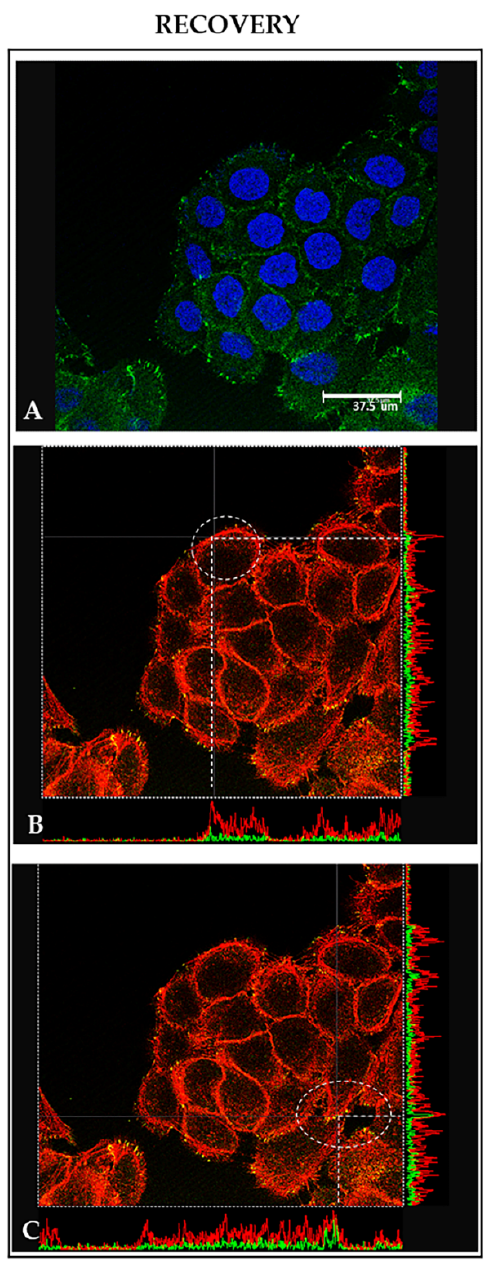
Figure 6. Representative images of colocalization analysis of vinculin (green) and F-actin (red) in HaCaT cells cultured in RPM for 24 h and then transferred into a normal gravitational field for a further 24 h (recovery conditions). In ( A ), vinculin distribution is shown; vinculin recovers almost completely the distribution pattern observed in 1g cultured cells. ( B , C ) Colocalization analysis of F-actin and vinculin. In the X/Y axes, at the level of the dotted lines, the colocalization (green and red picks) is shown. Colocalization in the recovery condition appears mainly in cell–cell contacts (( C ), dotted circle), while none or little colocalization is observed at the level of the periphery (( B ), dotted circle). Scale bars: 37.5 µ